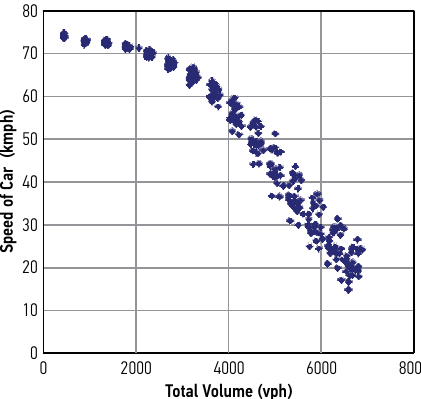
Fig. 1. Car speed (kmph) vs total volume (vph)